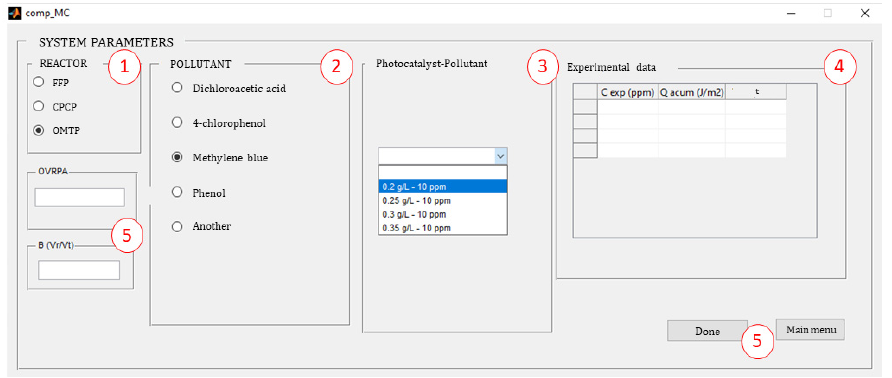
Figure 7. Database in the kinetic modeling module. (1) photoreactor configuration panel; (2) model pollutants panel; (3) photocatalyst-pollutant panel; (4) experimental data panel; (5) system parameters panel.